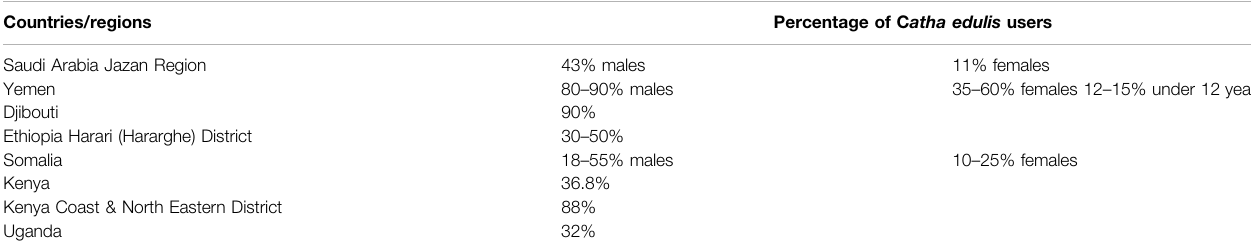
TABLE 3 | The estimated percentage of users in different countries/regions of East Africa and southwestern Arabian Peninsula.